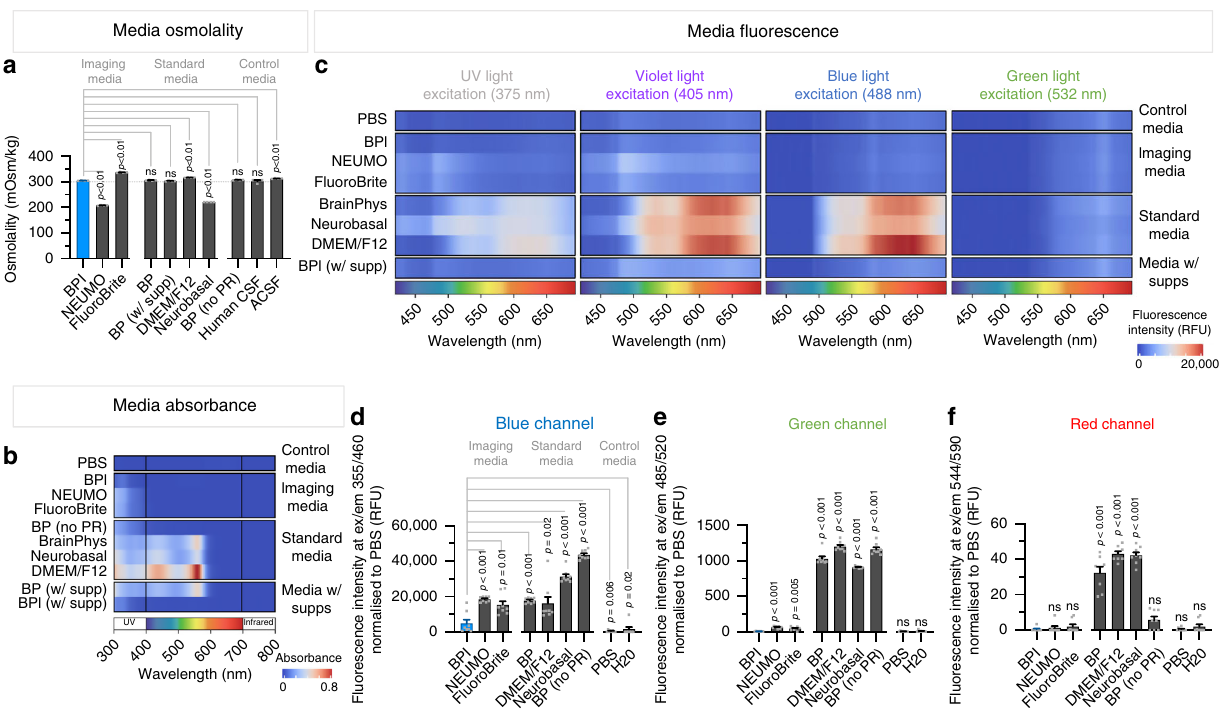
using healthy human iPSC-derived neurons in monolayers (Fig. 2a – c and Supplementary Figs. 2, 3) and organoids (Fig. 2d) or rat primary cortical neurons (Fig. 2e – f and Supplementary Fig. 1c – f). Live human iPSC-derived neurons were infected with lentivectors to express green (eGFP) using a synapsin promoter (Fig. 2a – c and Supplementary Figs. 2, 3). The human neurons were imaged live in standard BrainPhys or BPI with identical imaging parameters. BPI signi fi cantly increased signal-to- background ratios at the neurite and soma regions, and sig- ni fi cantly reduced mean background intensities (Fig. 2a – c). When combining analysis at soma and neurite regions, similar increases in signal-to-background ratios were observed. Reperfusing the cells with arti fi cial cerebrospinal fl uid (ACSF), after testing them subsequently in BPI and BP, recovered signal-to-background ratios in the background, soma and/or neurite regions to levels identical to BPI (Fig. 2a – c). This con fi rmed that the effect was not simply due to possible photobleaching. Overall, all the neuronal monolayer and organoid images in BPI showed increased signal- to-background ratios for lower wavelengths (blue and green) compared to all other media tested (standard BrainPhys, Figs. 2a – c, e, f and Supplementary Figs. 1c – f, 2, 3; organoid medium, Fig. 2d; BrainPhys without Phenol Red and NEUMO, Supplementary Fig. 1c – f). The live imaging of an assembly of brain-region speci fi c organoids (assembloids 27 ) in BPI also